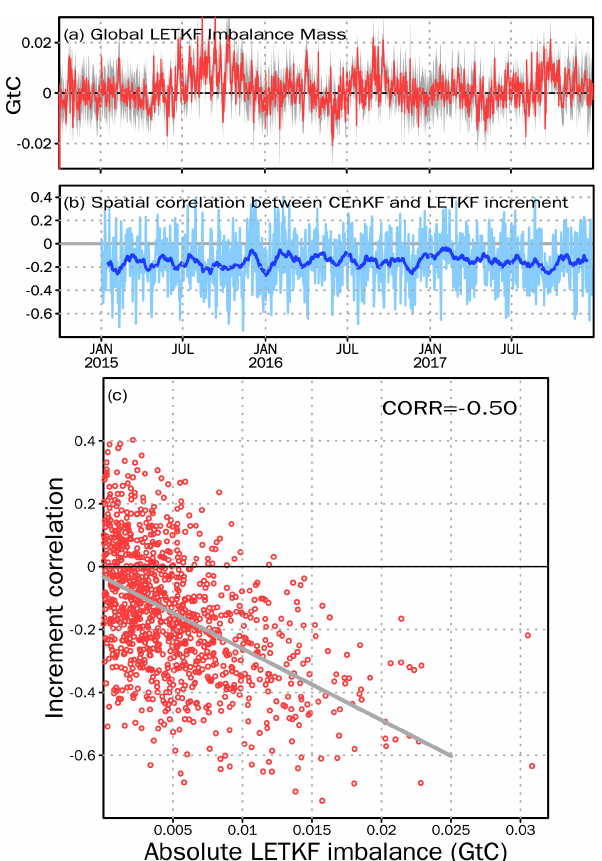
Figure 13. (a) The global mass imbalance caused by LETKF. The red line is the ensemble mean of the global mass imbalance. The gray shading indicates the imbalance ensemble variance. (b) The sky blue line is the surface spatial correlation between the CEnKF increment and the LETKF increment at each assimilation time. The blue line is calculated from the sky blue line using the 30d moving average method. Note that, during the spin-up period, the CEnKF is not applied. Thus, there are no correlations. (c) The red dots indicate the relationship between the increment correlation (sky blue line in panel b ) and the absolute LETKF imbalance (absolute value of red line in panel a ) at each assimilation time. The gray line is the linear least squares regression fits to the scattered dots. The correlation is shown in the upper right